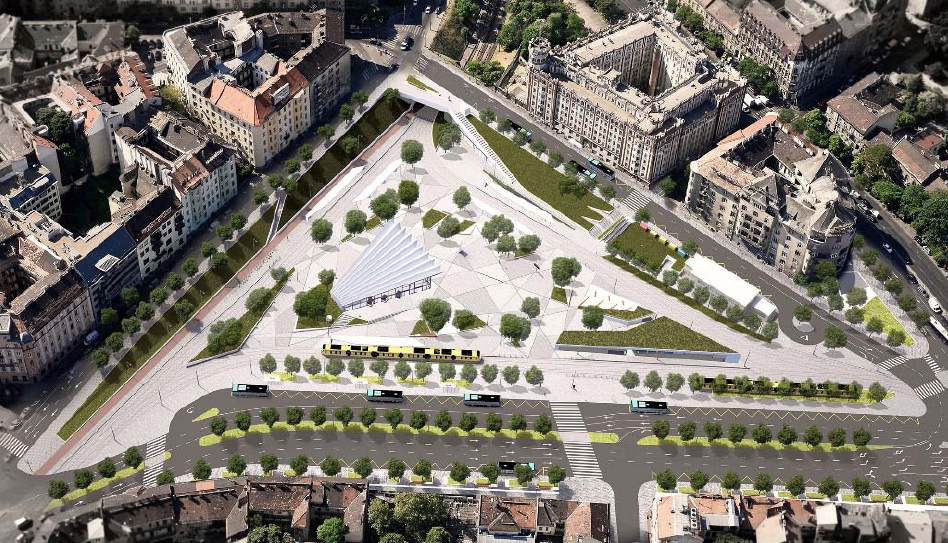
Figure 5. The open-space renovation design plan of Széll Kálmán Square. Amongst the artistic features that determine the atmosphere of the square, the most apparent is the historic relief map in front of the glass facade at the entrance to the metro (Figure 6). The pale green and brown patterns on two angularly arranged, irregular exposed concrete walls make a composition to experience not only through the visual, but also the tactile sense (Designer: Bar ó thy Anna and Szövets é g 39 Group). The source of the map is the ordnance survey map of Pest, Buda and Ó buda from 1823, which was